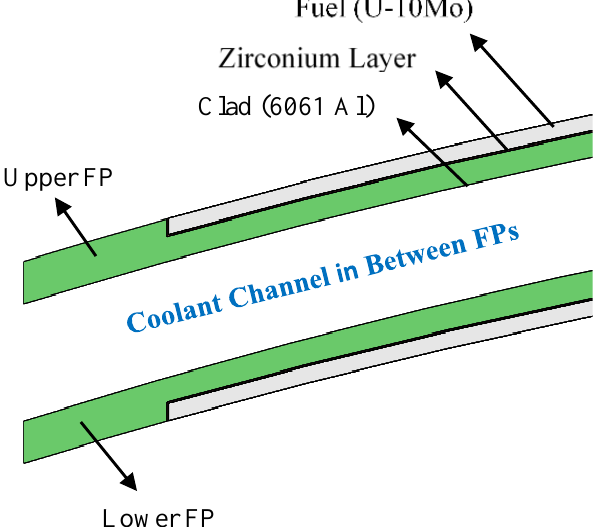
Figure 4. Cross-sectional-view of the simulated MSTR-HPCs’ hot-channel. Thermal hydraulic parameters for the model are presented in Table 2. Based on the design, ∆ T was 12 K, and the total coolant cross-sectional area for the active core was calculated to be 332.5 cm 2 . The calculated total mass flow rate was 39.86 kg/s. For the coolant channel, the calculated cross-sectional area and mass flow rate were 2.071 cm